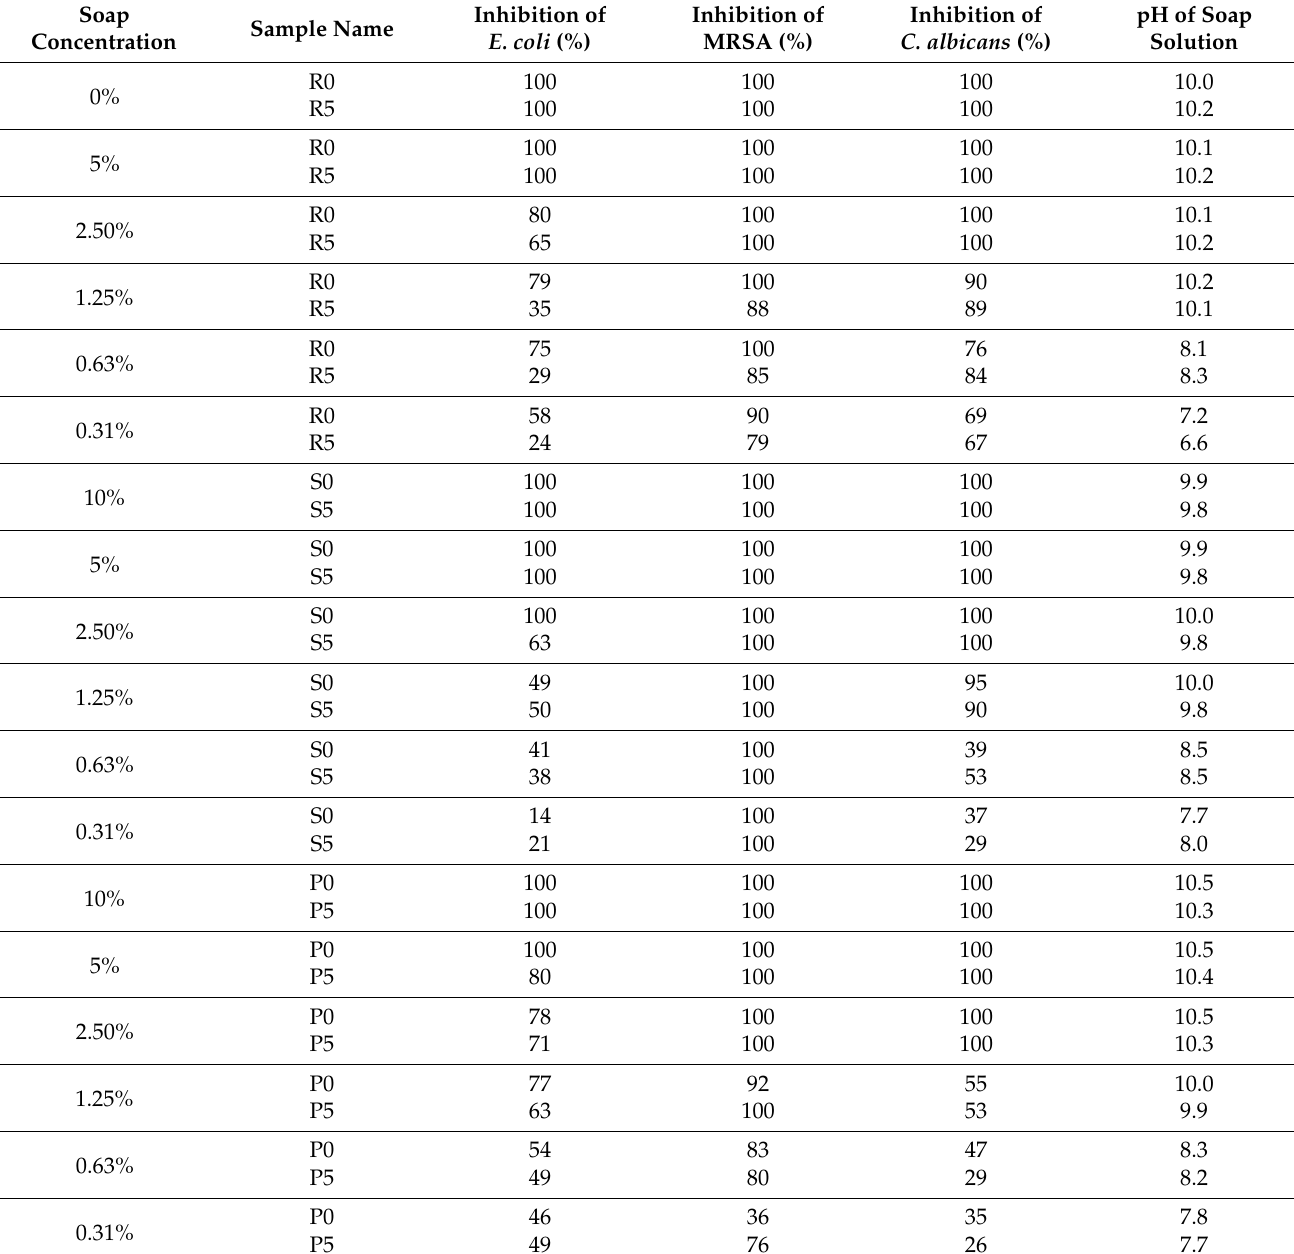
Table 4. Results for antimicrobial activity of soap